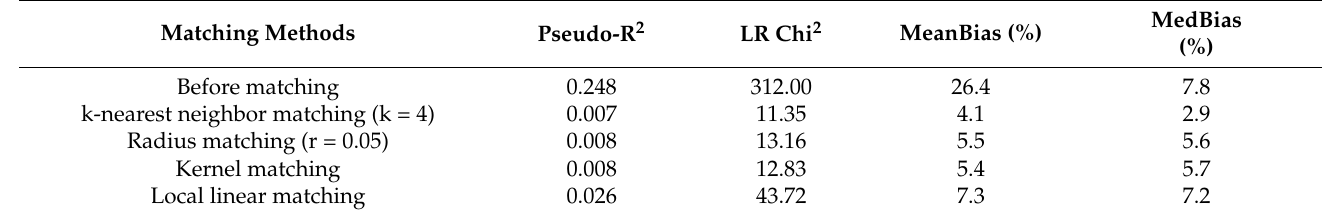
Table 6. Balance test.